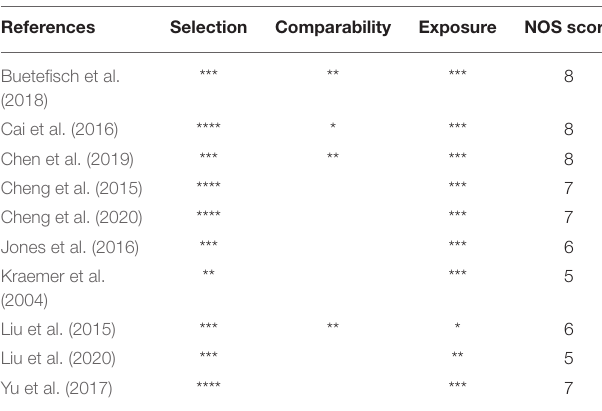
This table identifies “high” quality choices with a “star.” A study can be awarded a maximum of four stars ( **** ) within the Selection category and a maximum of three stars ( *** ) within the Exposure category. A maximum of two stars ( ** ) can be given for Comparability. Studies can be divided into very high group quality (NOS score = 9) and lower quality group (score < 9) for